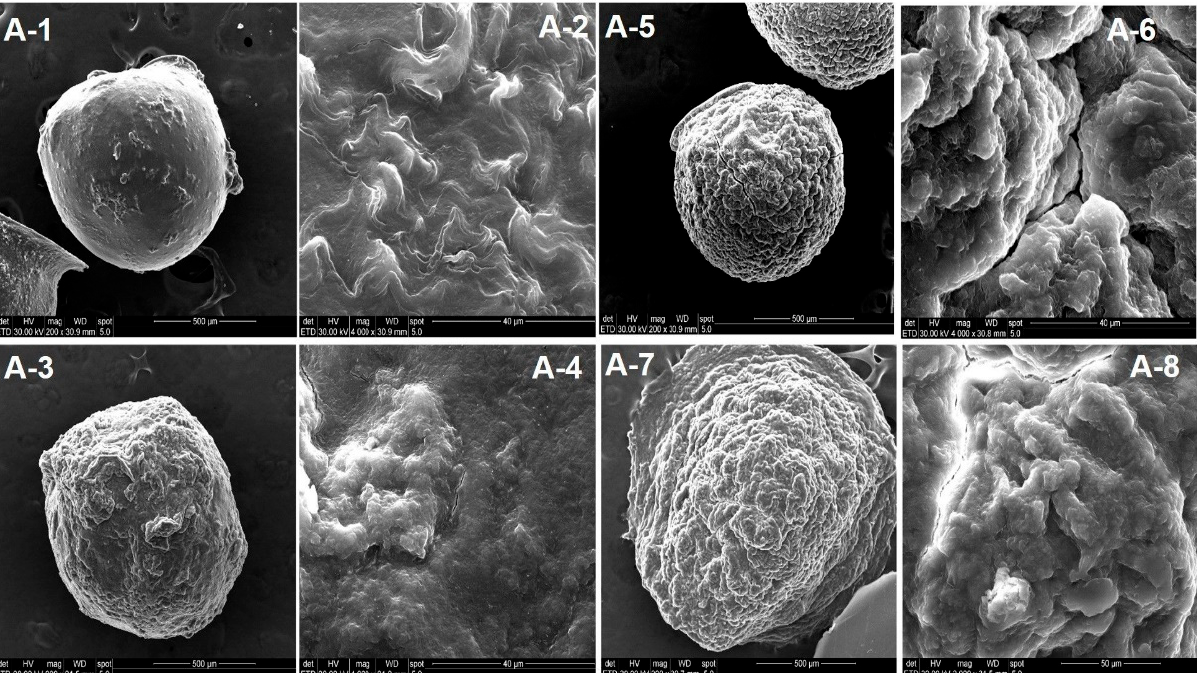
Figure 10. SEM images of the unloaded ( A-1 – A-8 ) hydrogel beads. Figures A-1 and A-2 display CS-TPP particles and their surface details. Layered CS-TPP beads with kCG for 1 h, 3 h, and 6 h are illustrated in figures A-3 , A-5 and A-7 , respectively, while their detailed surface textures are depicted in figure A-4 , A-6 and A-8 .